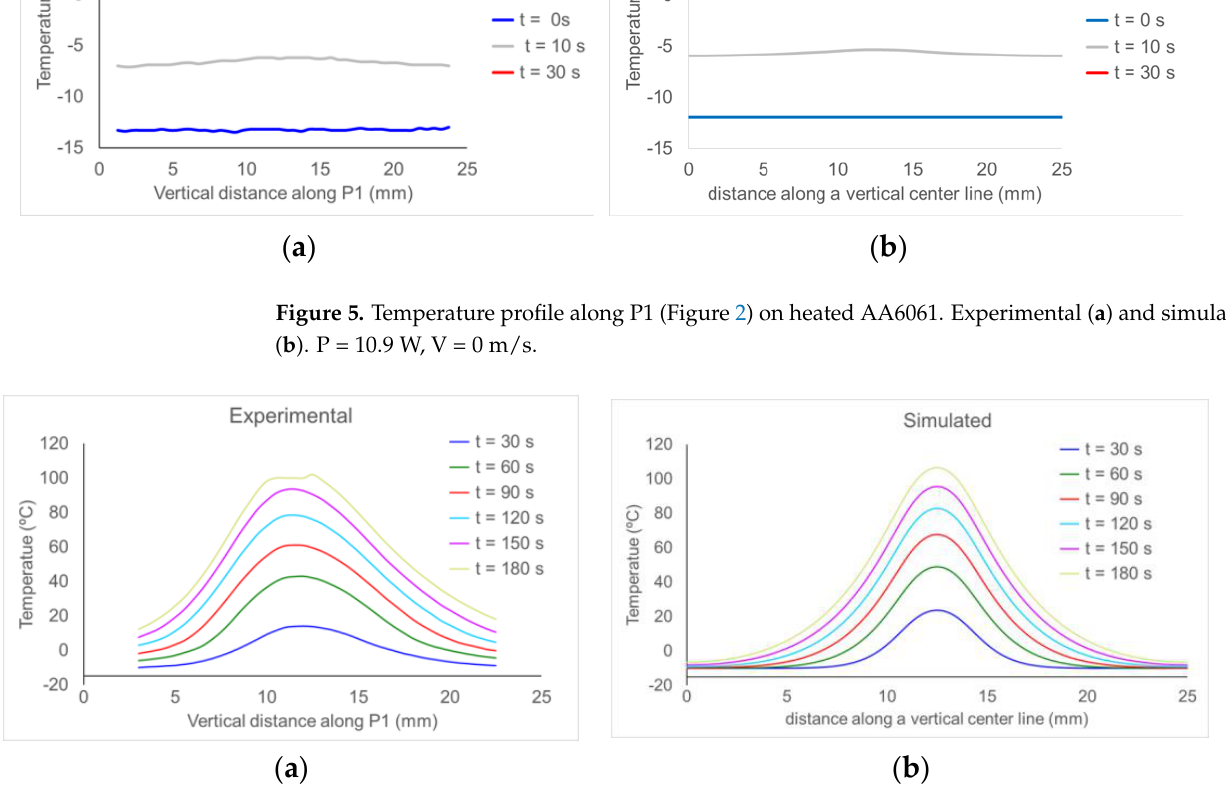
Figure 6. Temperature profile along P1 (Figure 3) on heated PTFE. Experimental ( a ) and simulated ( b ) as a function of time. ( b ) as a function of